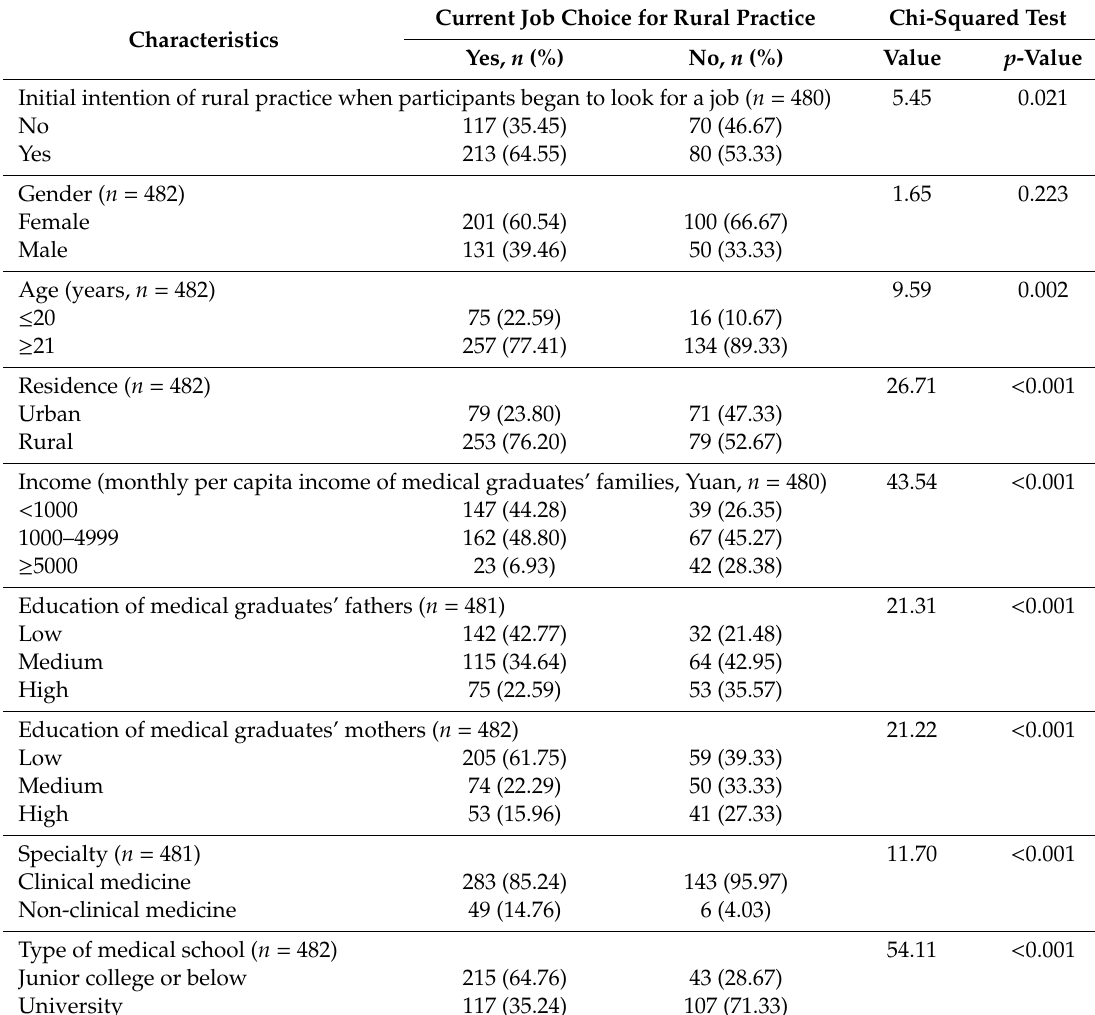
Table 2. Crosstab analyses and Pearson’s chi-squared